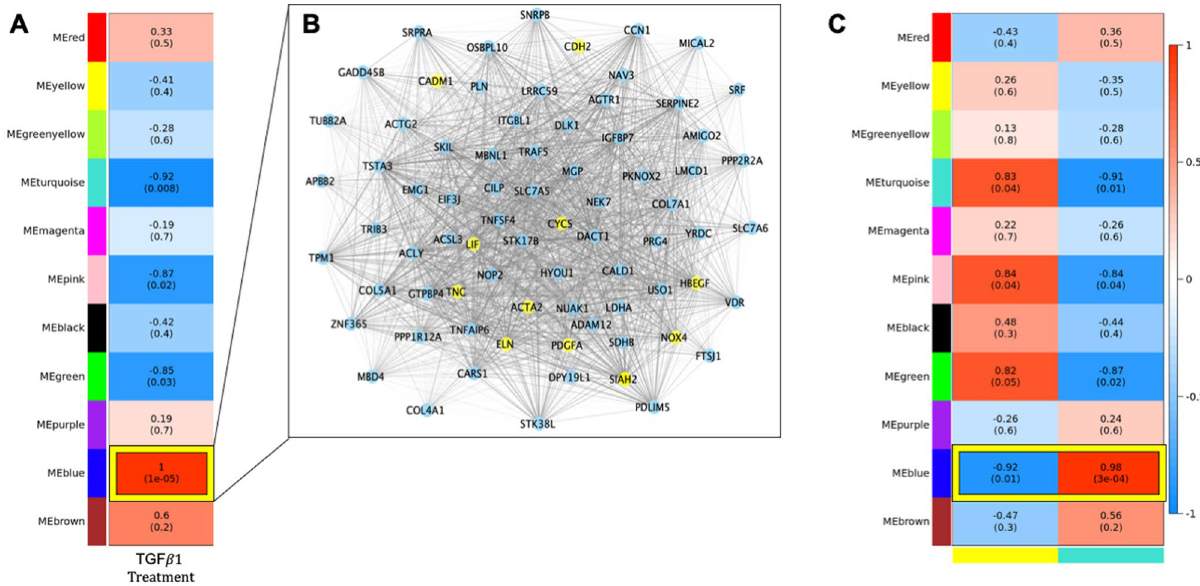
Figure 1. Results of integrative ‘omics analysis of proteomic and transcriptomic data generated from IMR- 90 cells with and without TGFβ1 treatment. ( A ) Transcriptomic module association with TGFβ1 treatment: Values in each cell represent correlation, in parentheses, with p-values between each module of co-expressed transcripts and TGFβ1 treatment. Heatmap shading corresponds to strength of association where darker red cells have higher upregulation and darker blue cells have higher downregulation based on correlation. Cells outlined in yellow withstand Bonferroni correction for multiple testing based on the number of modules generated. ( B ) Network visualization of hub genes in the blue transcriptomic module. Genes with a kME larger than 0.99 were selected for visualization in the blue module. The thickness of the edge corresponds to increasing topological overlap (TOM), a measure of the strength of correlation between transcript levels, which is the Pearson’s correlation obtained from the adjacency matrix. Nodes labeled in yellow correspond to single genes in the blue module that are annotated as associated with pirfenidone and/or nintedanib treatment. ( C ) Results from integration of transcriptomic and proteomic data. Values in each cell represent correlation, p-values in parentheses, between each module of co-expressed transcripts with TGFβ1 treatment and modules of co-expressed proteins. The y-axis corresponds to transcriptomic modules generated using WGCNA. The x-axis corresponds to the yellow and turquoise proteomic modules. Individually, the yellow and turquoise proteomic modules were significantly correlated with TGFβ1 treatment (depicted in Fig. (Fig. 1C: r = − 0.92, p = 0.01). Several of the TGFβ1 significantly differentially expressed genes (Table S5) had encoded proteins which were hub members of the yellow ( COL4A1) and turquoise ( CNN1, TNS1, COL5A1, and PDLIM5) proteomics module (Fig. 2B,C). The five genes and proteins were enriched for pro-fibrotic path- ways including collagen formation (REACTOME collagen formation, FDR p-value = 0.021), ECM proteoglycans (REACTOME ECM proteoglycans, FDR p-value = 0.017), and PDGF signaling (REACTOME PDGF Signaling, FDR p-value = 0.016), among others. Novel fibrotic biomarkers common to pirfenidone, nintedanib, and TGFβ1 signaling. Of the genes annotated as response to pirfenidone and/ or nintedanib treatment, 264 genes were specific to pirfenidone and 150 genes were specific to nintedanib. A total of 149 genes were identified as being associated with both pirfenidone and nintedanib treatment (Table S8). The blue module was significantly enriched (FDR-p = 0.0395) for transcripts from genes associated with both pirfenidone and nintedanib treatment. Among these, 4 genes ( BASP1, HSD17B6, CDH11 , and TNS1 ) associated with pirfenidone were identified as novel genes not found in known pathways containing TGFβ1 (Table 1). Additionally, 5 genes ( CLINT1, CADM1, MTDH, SYDE1 , and MCTS1 ) associated with nintedanib treatment have not previously been classified as involved with TGFβ1 sign- aling (Table 1). One gene, MYDGF , was highlighted as being associated with both pirfenidone and nintedanib and not a member of known TGFβ1 signaling pathways (Table 1).